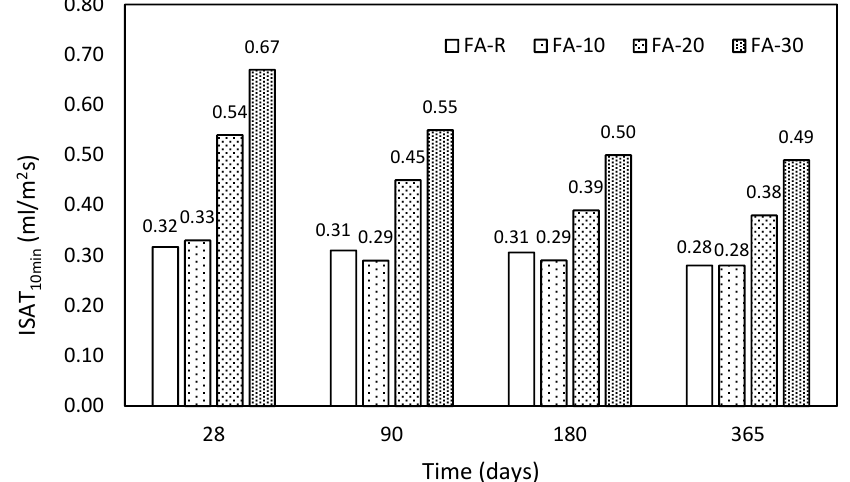
Figure 8. Obtained results of ISAT in time.